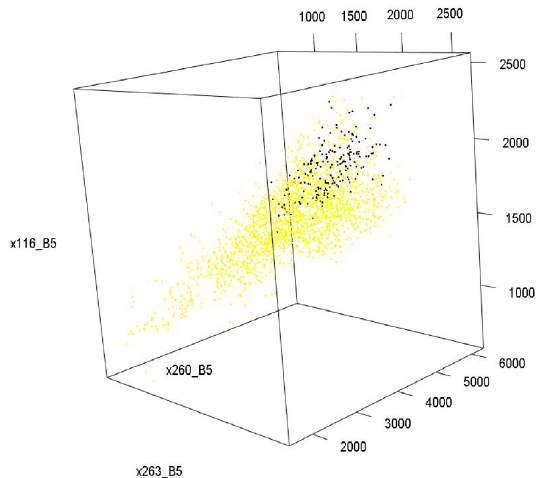
Figure 4. An example of separation between autumn olive (black) and other land classes (yellow) in a 3 dimensional space, composed of the near-IR band over different